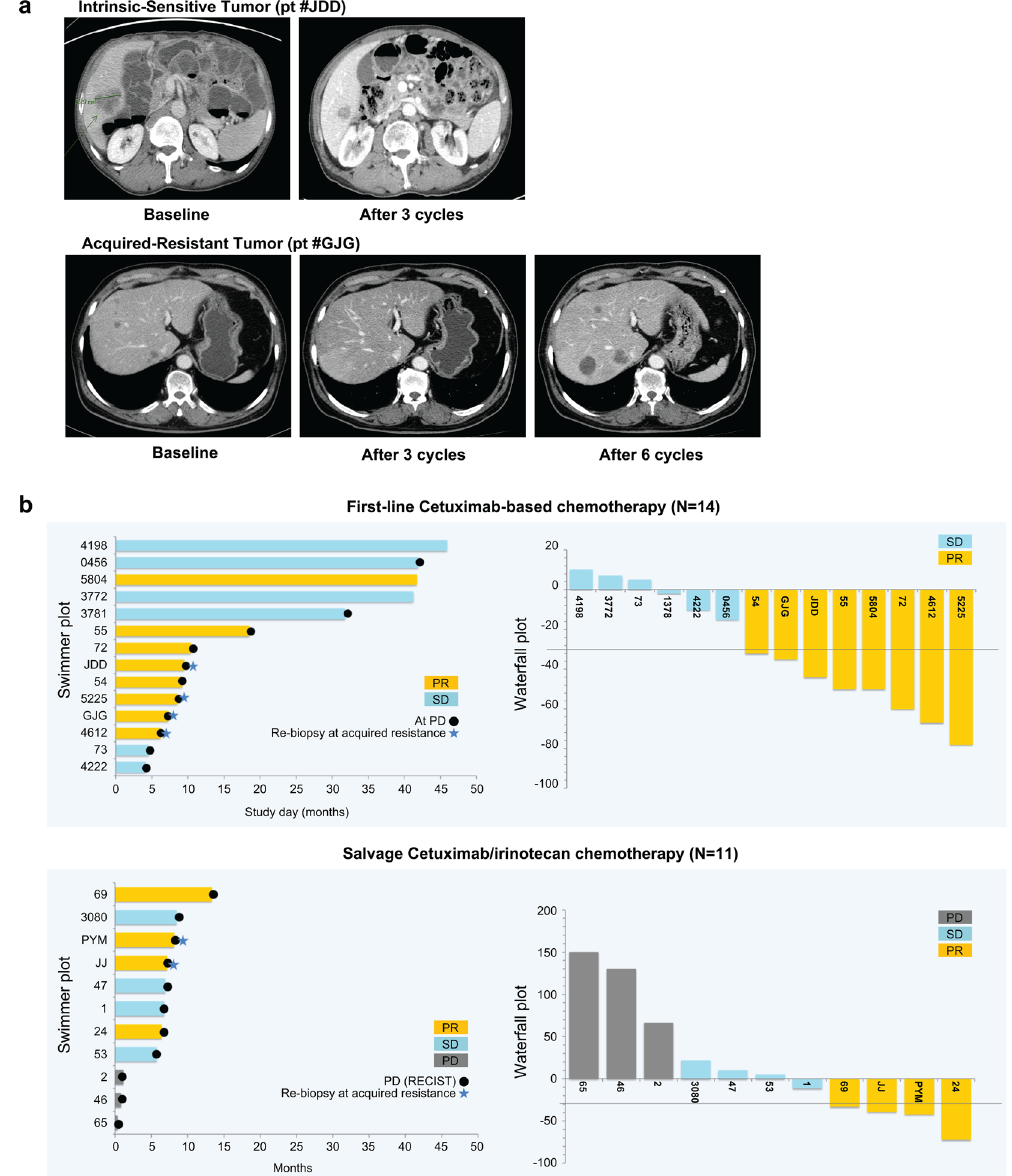
Figure 1. Clinical response to cetuximab. ( a ) Representative computed tomography scans from cetuximab intrinsic-sensitive and acquired-resistant colorectal cancer (CRC) patients. ( b ) Horizontal bar plots represent time (months) for which patients were on cetuximab treatment until progressive disease (PD) (black dots) for first-line cetuximab-based chemotherapy (n = 14) (top) or salvage cetuximab/irinotecan chemotherapy (n = 11) (bottom). Orange, blue, and grey bars indicate partial response (PR), stable disease (SD), and PD, respectively. Blue stars indicate successful re-biopsy in patients who achieved PR and then developed acquired resistance. Vertical waterfall bar plots in the right panels show the percent change in tumour size (y-axis) from baseline during cetuximab treatment. As defined by RECIST criteria, patients who achieved a shrinkage in tumour size of > 30% were classified as PR and ‘intrinsic sensitive’ for our